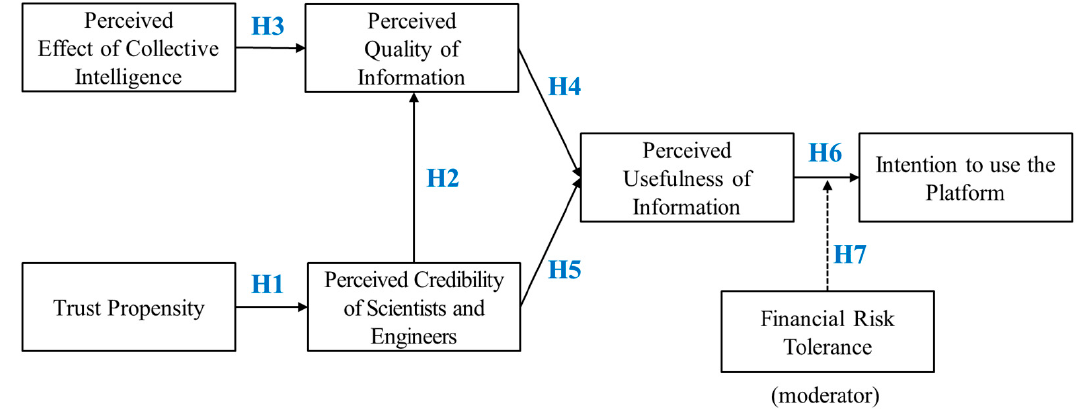
Figure 1. Research framework.